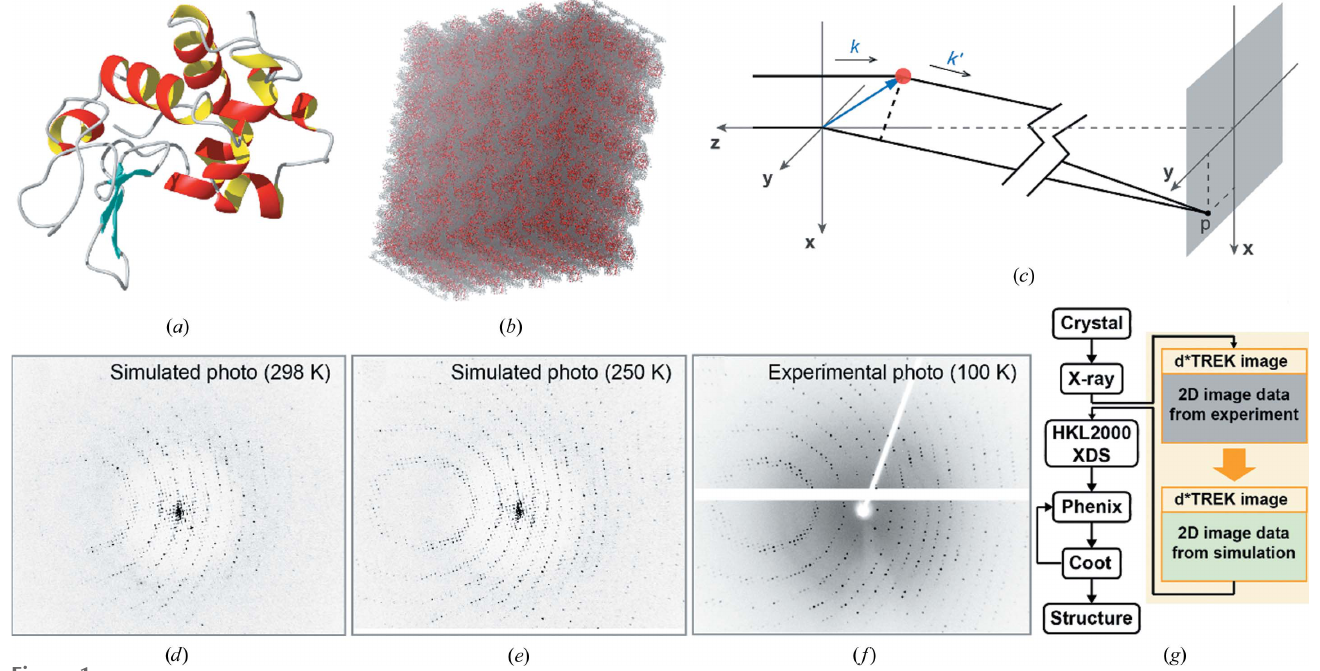
Figure 1 Generation of diffraction photographs from an MD trajectory of crystalline lysozyme. ( a ) The structure of lysozyme solved in-house (tetragonal lattice, 2.1 A ˚ resolution). ( b ) A 5 (cid:2) 5 (cid:2) 5 supercell of crystalline lysozyme in the MD simulation, containing 1000 protein molecules, 391 250 water molecules and 10 000 Cl (cid:3) ions. ( c ) Diagram illustrating the calculation of an X-ray diffraction photograph based on the Huygens–Fresnel principle. The red dot represents the position of an atom in the crystal. k and k 0 denote wavevectors before and after scattering, respectively. The point p represents a pixel on the receiver plane. ( d ) A simulated diffraction photograph from a 300 ns MD trajectory of the lysozyme crystal supercell at 298 K. ( e ) A simulated diffraction photograph from a 300 ns MD trajectory of the lysozyme crystal supercell at 250 K. ( f ) The experimental diffraction photograph taken at the same crystal rotation angle as the simulated photographs ( d ) and ( e ). ( g ) Flowchart of the structure back-calculation procedure using MD-based simulated diffraction photographs. In brief, the digitized diffraction images in the experimental data files were replaced with the simulated images, and these files were then used as input for the standard pipeline to solve the crystal structure, with our experimentally solved crystal structure as the molecular-replacement